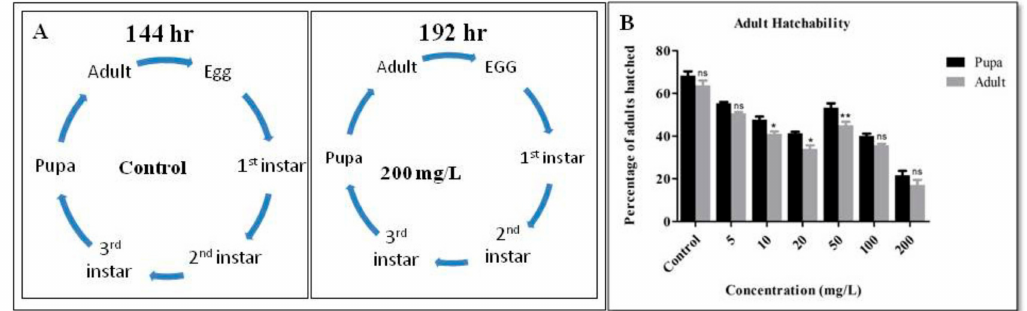
Figure 1. ( A ) The developmental cycle of control flies compared to the highest concentration of Wood-based Cellulose Nanofibrils (CNF) treatment, a delay of about 48 h was observed. ( B ) Percentage of the adult flies hatched from the pupa in di ff erent concentration of treatment vials compared to the control.